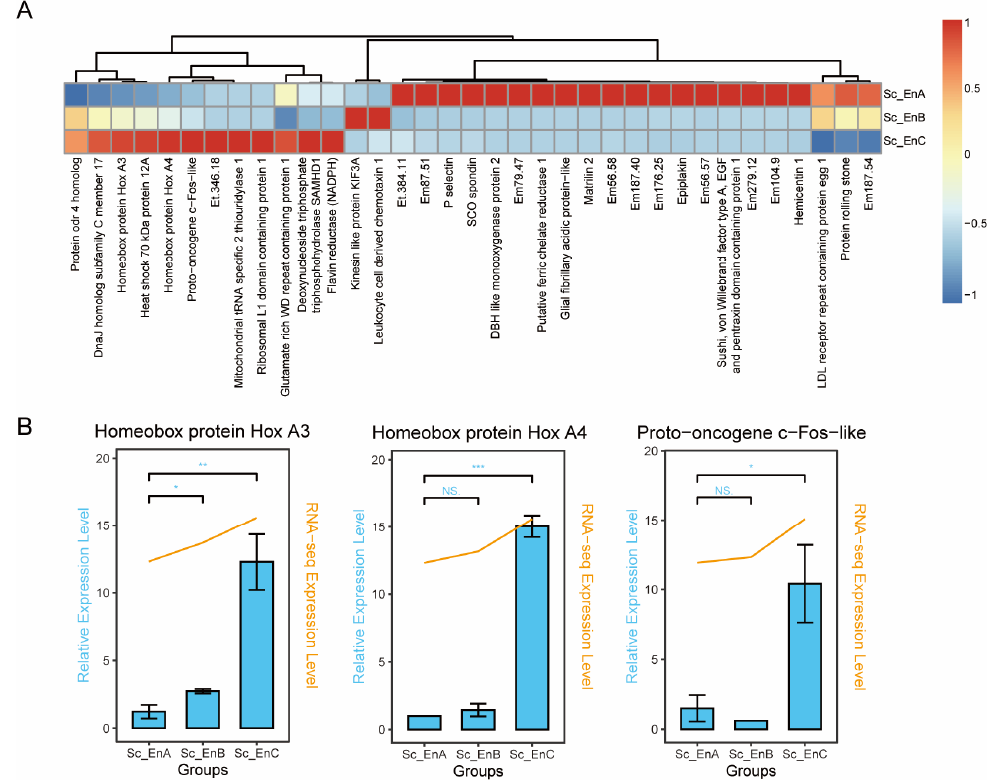
Figure 2. Identification of DEGs on endostyle longitudinal levels. ( A ) The expression level of up- or down-regulated genes was visualized with a heatmap for longitudinal segmented samples. Genes without functional annotation were labeled as shorted gene IDs with “Em” or “Et” starting. ( B ) qRT-PCR verifies the expression trend of DEGs in longitudinal levels of the endostyle. The blue bar corresponds to the relative expression level in qRT-PCR verification, based on which the significant signal was labeled. The orange broken line corresponds to the RNA-seq expression level in transcriptomic data. * p < 0.05. ** p < 0.01.*** p < 0.001. n.s. Not significant.